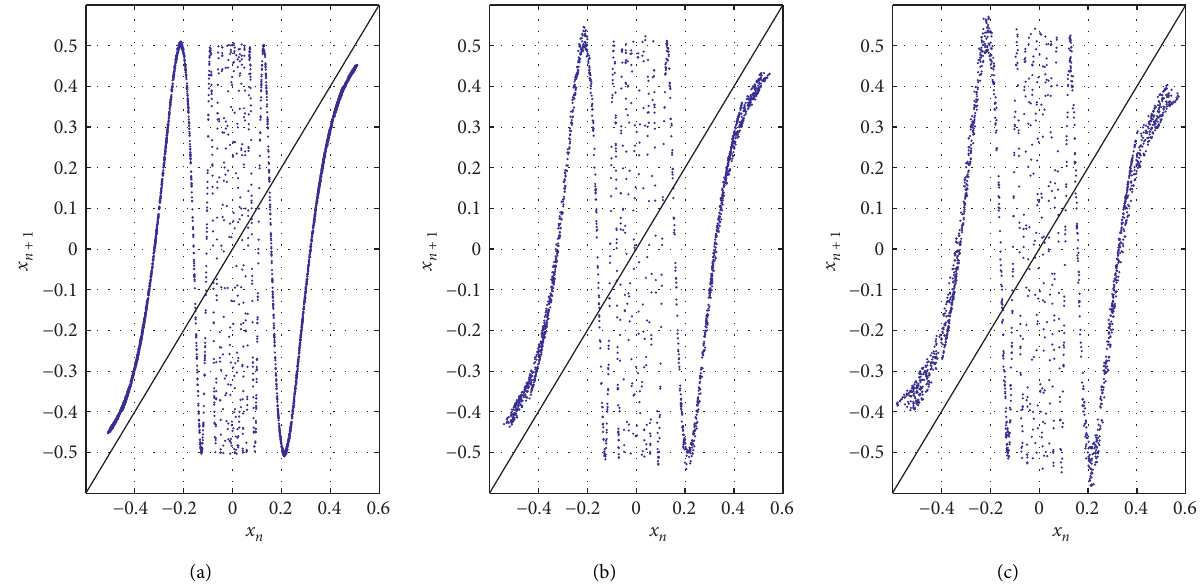
Figure 2: Different chaotic attractors of the fractional map (8) for system parameters A � 0 . 5 , B � 0 , C � 3 and different values of μ : (a) μ � 0 . 9 and (b) μ � 0 . 8. (c) μ � 0 .